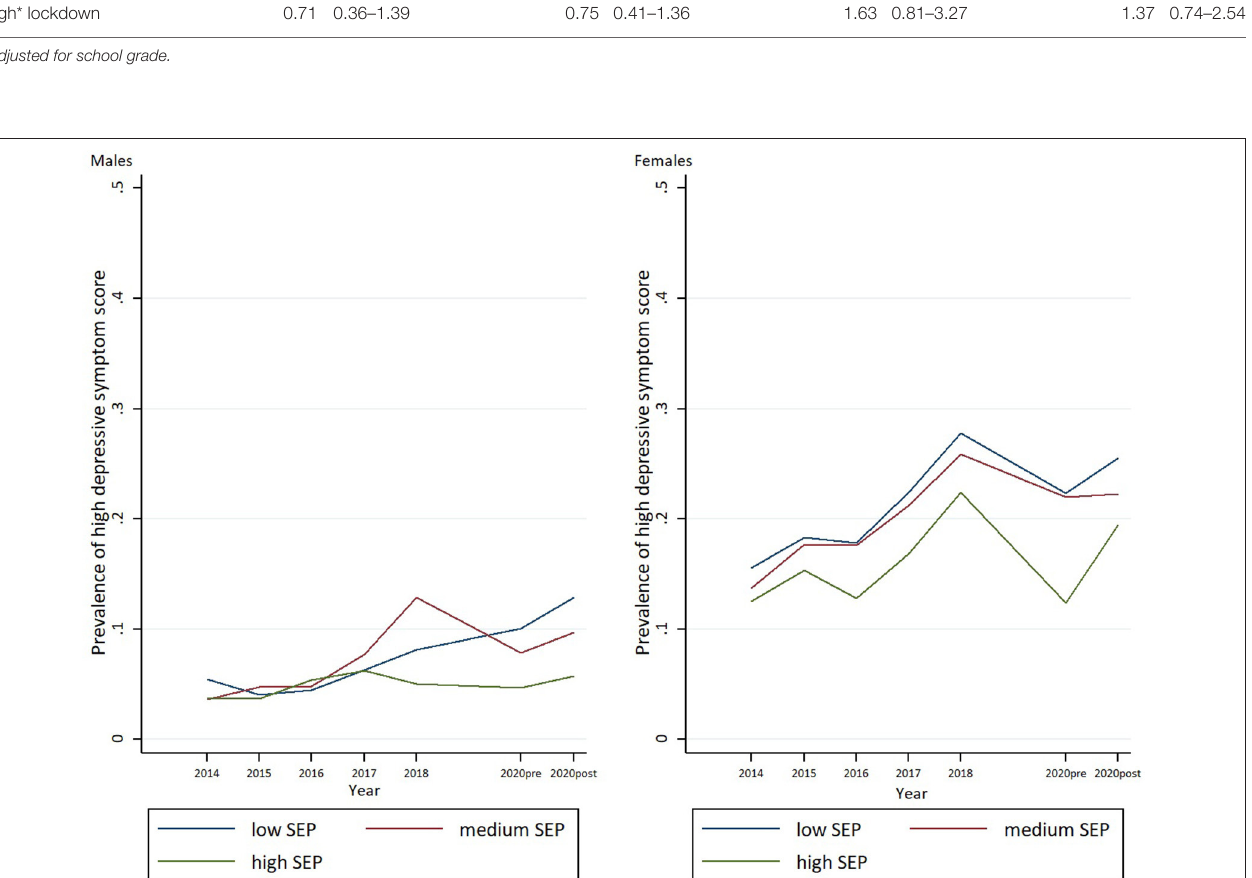
Frontiers in Public Health |